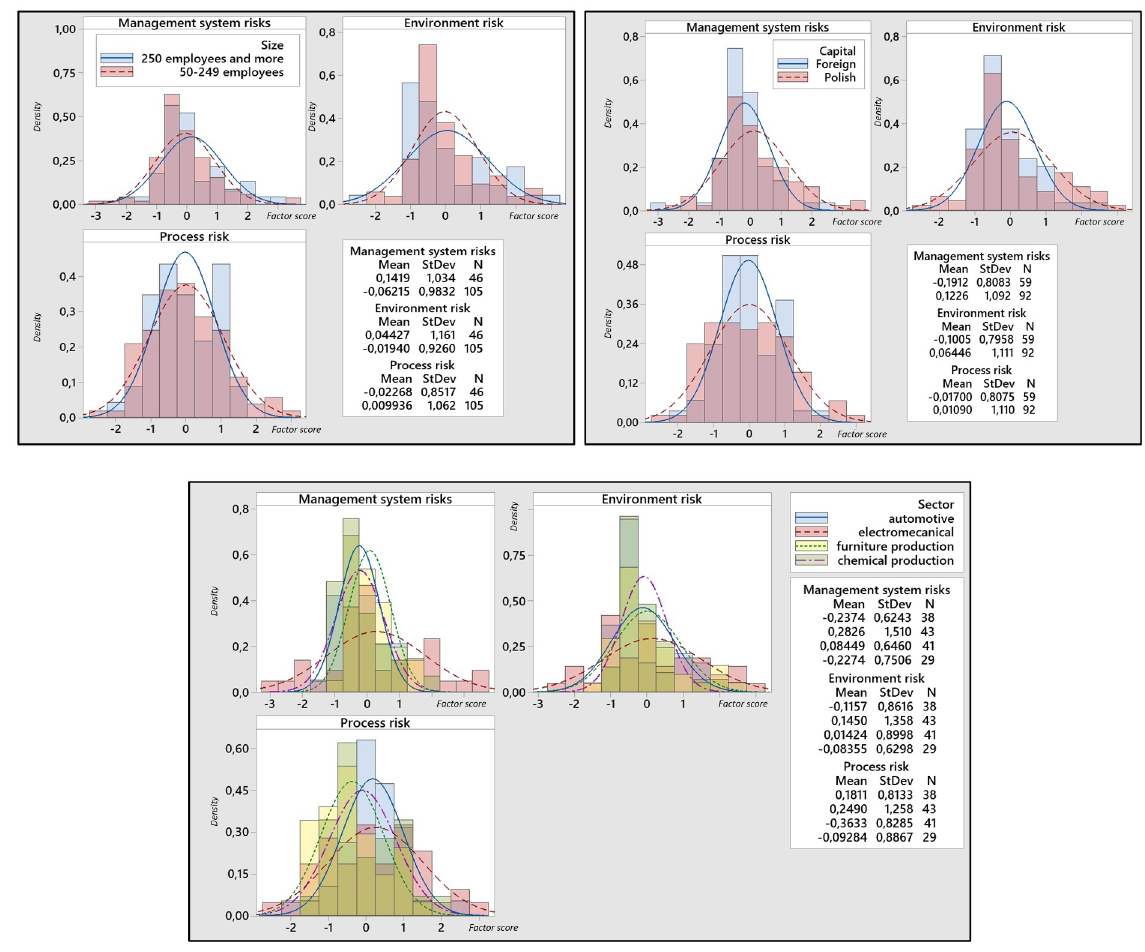
Fig 5. Relationships between size, capital and sector and three identified meta-factors of risks.